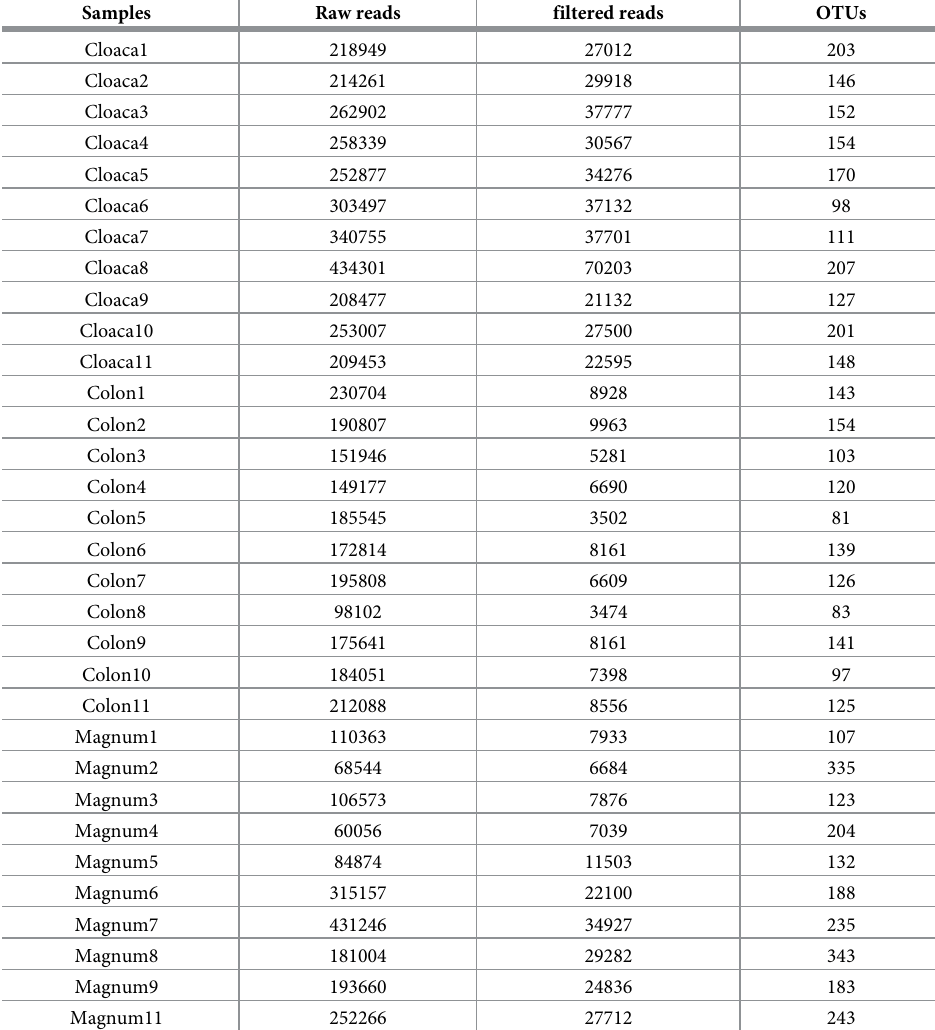
Table 1. Raw reads, filtered reads, and total OTUs of each